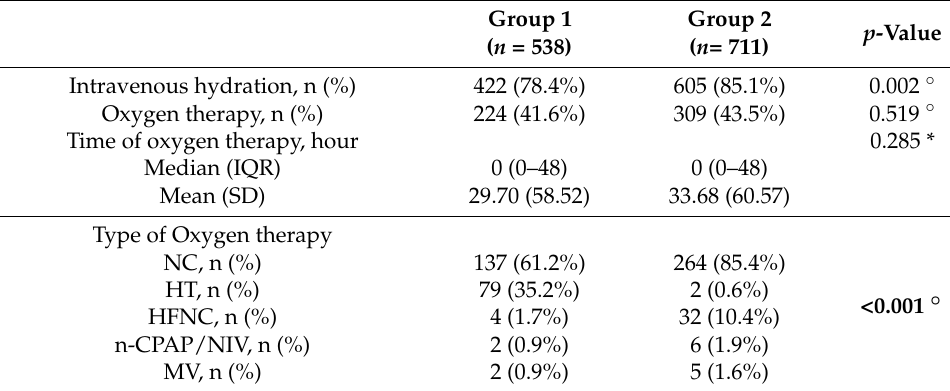
Table 3. Use of supportive therapy in the different population groups.